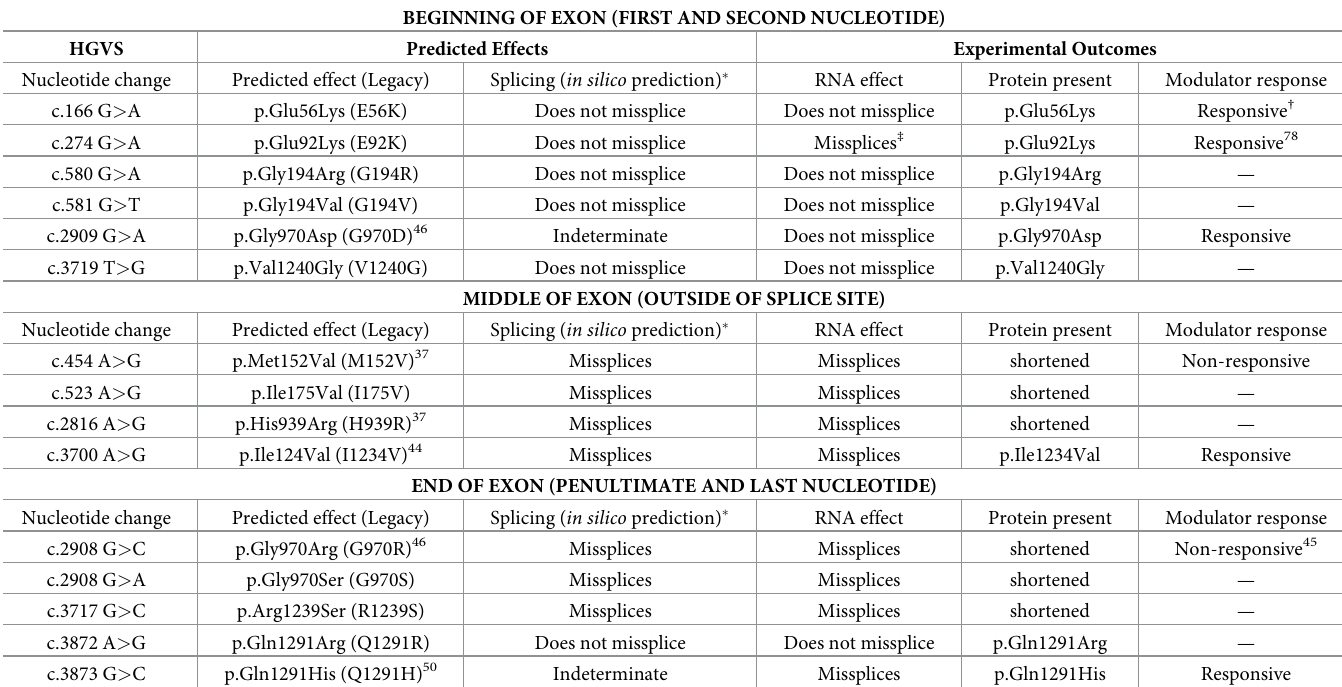
Table 1. Exonic variants evaluated for impact on CFTR mRNA